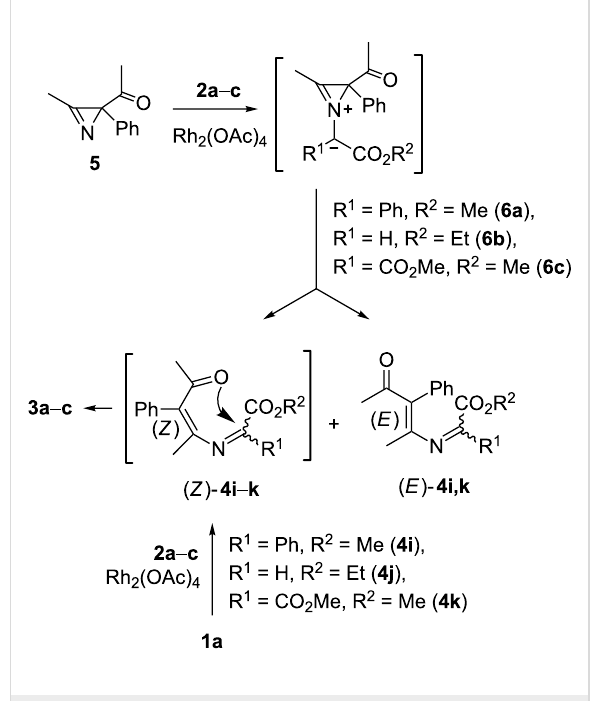
Scheme 5: Reaction of complementary isoxazole 1a and azirine 5 with diazo